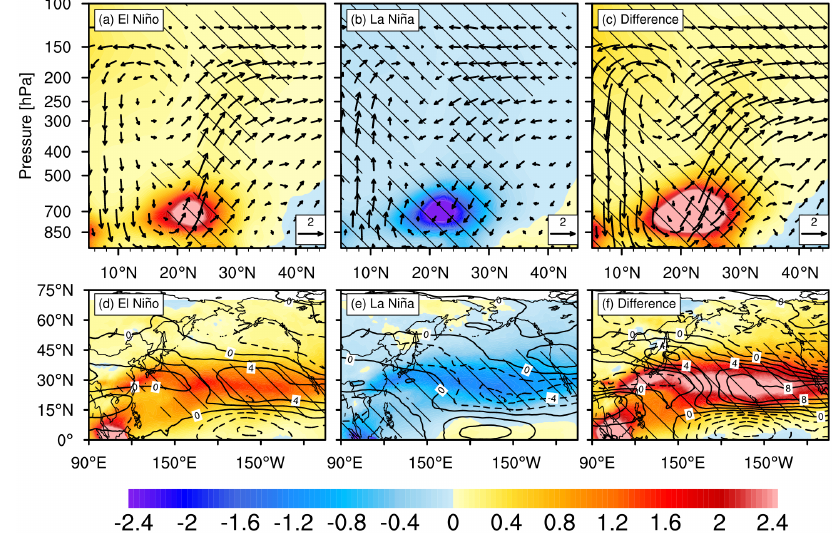
Figure 8. (a–c) Vertical sections of composite anomalies of spring CA mass mixing ratio (shading; 10 − 6 gkg − 1 ) and meridional and vertical velocities (vector; ms − 1 and 10 − 2 ms − 1 , respectively) averaged over 110–125 ◦ E during (a) El Niño and (b) La Niña and (c) their difference (El Niño minus La Niña). (d–f) Same as Fig. 4, except for 300hPa CA mass mixing ratio (shading; 10 − 7 gkg − 1 ) and zonal wind (contour with interval of 4ms − 1 ). Hatching denotes the anomalies statistically significant at the 95% confidence level based on the Student’s t